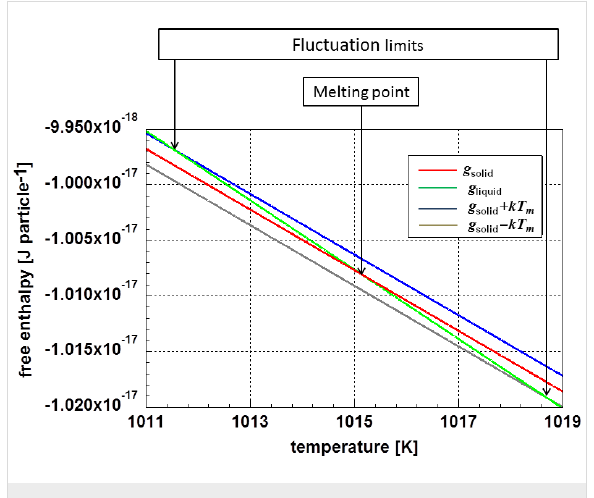
Figure 1: Free enthalpy for a 2 nm gold particle in solid and liquid phase. Additionally, this graph shows the fluctuation limits according to Equation